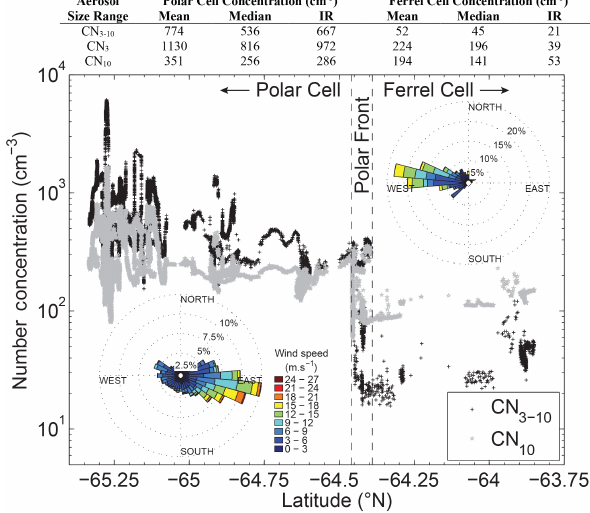
Figure 1. Thirty-two days of ship-based measurements of aerosol above the sea ice (south of the ice edge at 62 ◦ S) show a sharp jump in aerosol number concentration moving south across the po- lar front. Wind roses, calculated using in situ data from either side of the front confirm the expected easterly and westerly patterns of the polar and Ferrel cells respectively. Aerosol statistics (mean, median and the interquartile range (IR)) are given